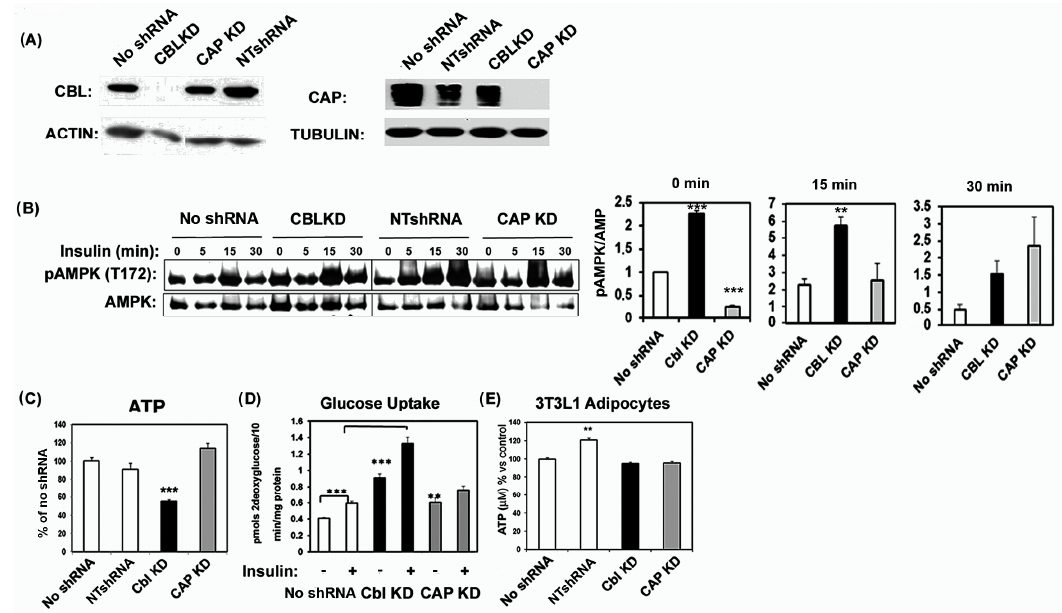
Figure 1. CBL depletion in C2C12 myotubes decreases ATP levels and enhances AMPK activity and glucose transport. ( A ) Western blot analysis showing knock down of Cbl and CAP in C2C12 myotubes. Whole cell lysates obtained from untransfected cells (None) or from cells expressing shRNAS for CBL (CBL KD), or CAP (CAP KD), or non-targeting shRNAs (NTshRNA) were immmunoblotted with specific antibodies as indicated ( B ) Activation of AMP regulated kinase (AMPK) in CBL KD, CAP KD, and control cells. Differentiated myotubes were serum starved and either left untreated (0 min) or treated with 100 nM insulin for 15 or 30 min Cellular lysates were obtained, separated by SDS-PAGE and immunoblotted with antibodies for phospho-AMPK (T172) and total AMPK. The right panel shows the quantification of normalized phospho-AMPK from Western blot data from n = 3 experiments at 0, 15, and 30 min post-treatment with 100 nM insulin. Quantification was carried out with Image J, NIH. Graphs show mean ± SEM values. Statistical analysis: one-way ANOVA to no shRNA expressing cells. ** indicates p < 0.01; *** p < 0.001. ( C ) ATP content in cellular lysates of differentiated C2C12 cells expressing no shRNAs, NTshRNAs or shRNAs specific for CBL or CAP. Graphs show mean ± SEM values of data combined from 3 experiments each with n = 3–4 biological replicates per group. ATP values are expressed as % of values in control cells. Statistical analysis: one-way ANOVA. *** indicates p < 0.001. ( D ) 3 H-2-deoxyglucose transport in C2C12 myotubes. Uptake was measured in basal (non-stimulated) conditions and following the stimulation of insulin (100 nM, 30 min) No shRNA-expressing cells or cells expressing shRNAs for CBL or CAP genes as indicated. Data show a mean ± SEM of a representative experiment with n = 4 biological replicates. Statistical analysis: one-way ANOVA to NTshRNA-expressing cells. ** indicates p < 0.01; *** p < 0.001. ( E ) ATP cellular content in differentiated 3T3L1 adipocyte cells expressing no shRNA, NTshRNA or shRNAs specific for CBL or CAP. Data show mean ± SEM of n = 4. ** indicates p < 0.01 compared to control (No shRNA) .